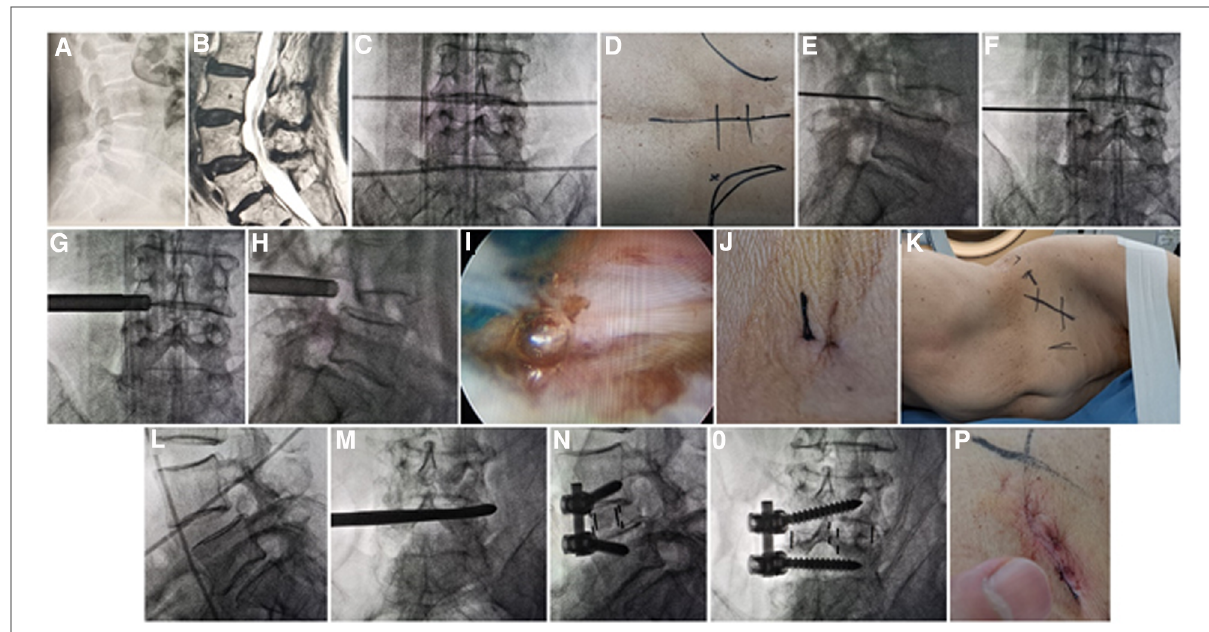
FIGURE 1 ( A ) X-ray and ( B ) MRI showed L4 Spondylolisthesis (I°) caused by degeneration in a 76-year-old female patient. Metal rods were placed transversely across the center of the target disc on ( C ) posteroanterior C-arm view to draw transverse lines. ( D ) The aimed reference point of puncture at surface was identi fi ed by the intersection of transverse line and longitudinal midline, and the entrance point of puncture (Gu ’ s point) was located at the corner of fl at back turning to lateral side. During puncture, once resistance disappeared, the C-arm view was taken to ensure that the tip of puncture needle was in the intracanal area close to the posterior wall of disc on ( E ) lateral x-ray and near the lateral border of pedicle on ( F ) posteroanterior x-ray. During press-down enlargement of foramen, when resistance disappeared, the tip of reamer should exceed the medial border of pedicle on ( G ) posteroanterior C-arm view and reach close to the posterior wall target disc on ( H ) lateral C-arm view. Under ( I ) endoscopic view, the compressed nerve root was freed after the hypertrophic ligamentum fl avum and herniated disc were removed. ( J ) The stab incision of about 8 mm for PTES was closed. ( K ) Patient was placed into right decubitus position for mini-incision OLIF and anterolateral screws rod fi xation. The anterior line of L4/5 intervertebral space was positioned using ( L ) C-arm view. The spatula was inserted into L4/5 intervertebral space to cut the contralateral fi brous annulus, which was con fi rmed by ( M ) x-ray image. After the OLIF cage was placed into disc space parallel to the endplate and anterolateral screws rod fi xation was performed, ( N ) lateral and ( O ) posteroanterior C-arm view con fi rmed good position of internal instruments. ( P ) The mini-incision of OLIF was sutured fi nally. PTES, percutaneous transforaminal endoscopic surgery; OLIF, oblique lumbar interbody fusion.